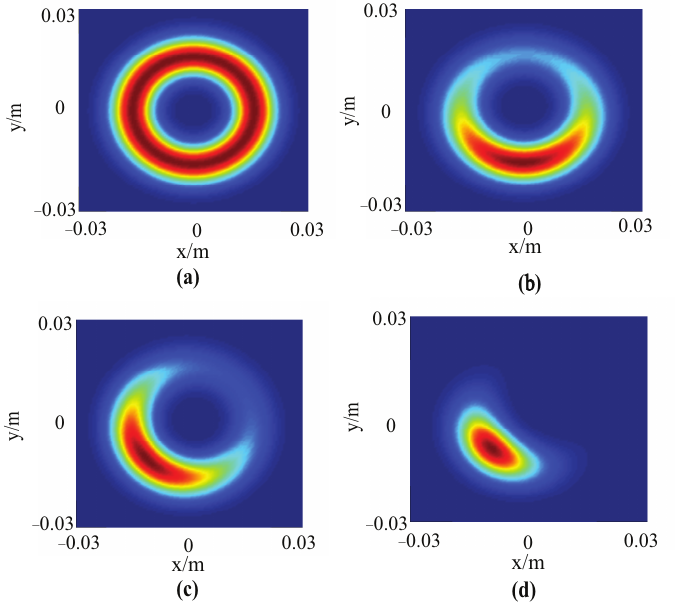
Figure 3. Contour graphs of the normalized average intensity of the OAHGSM vortex beam with differ- ent position factors propagating through anisotropic oceanic turbulence at z = 100 m. ( a ) A x = A y = 0, ( b ) A x = 0, A y = 0.001 m, ( c ) A x = 0.001 m, A y = 0.001 m, ( d ) A x = 0.005 m, A y = 0.005